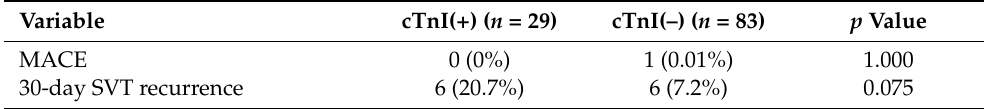
Table 4. Clinical outcomes of patients with positive or negative